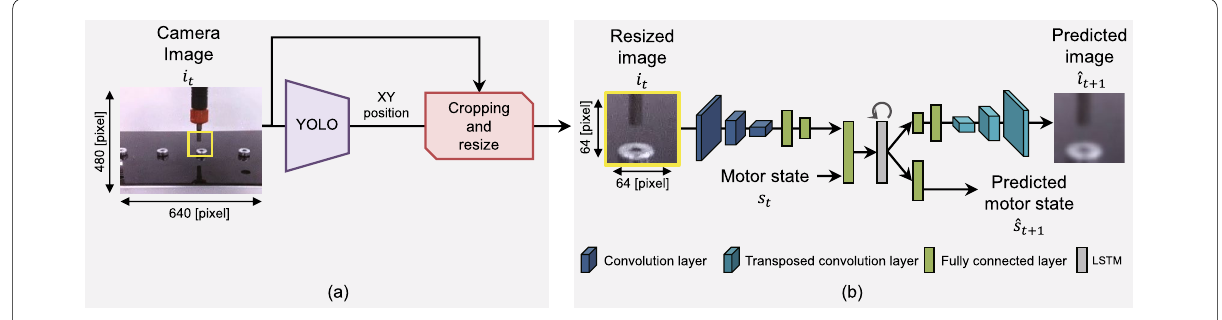
Fig. 4 Network architecture of sensorimotor